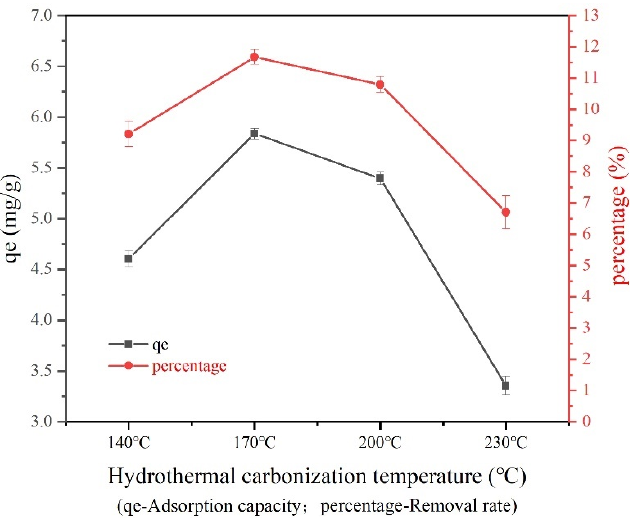
Figure 7. Effect of hydrothermal temperature on removal efficiency and adsorption capacity of Cd 2+ .